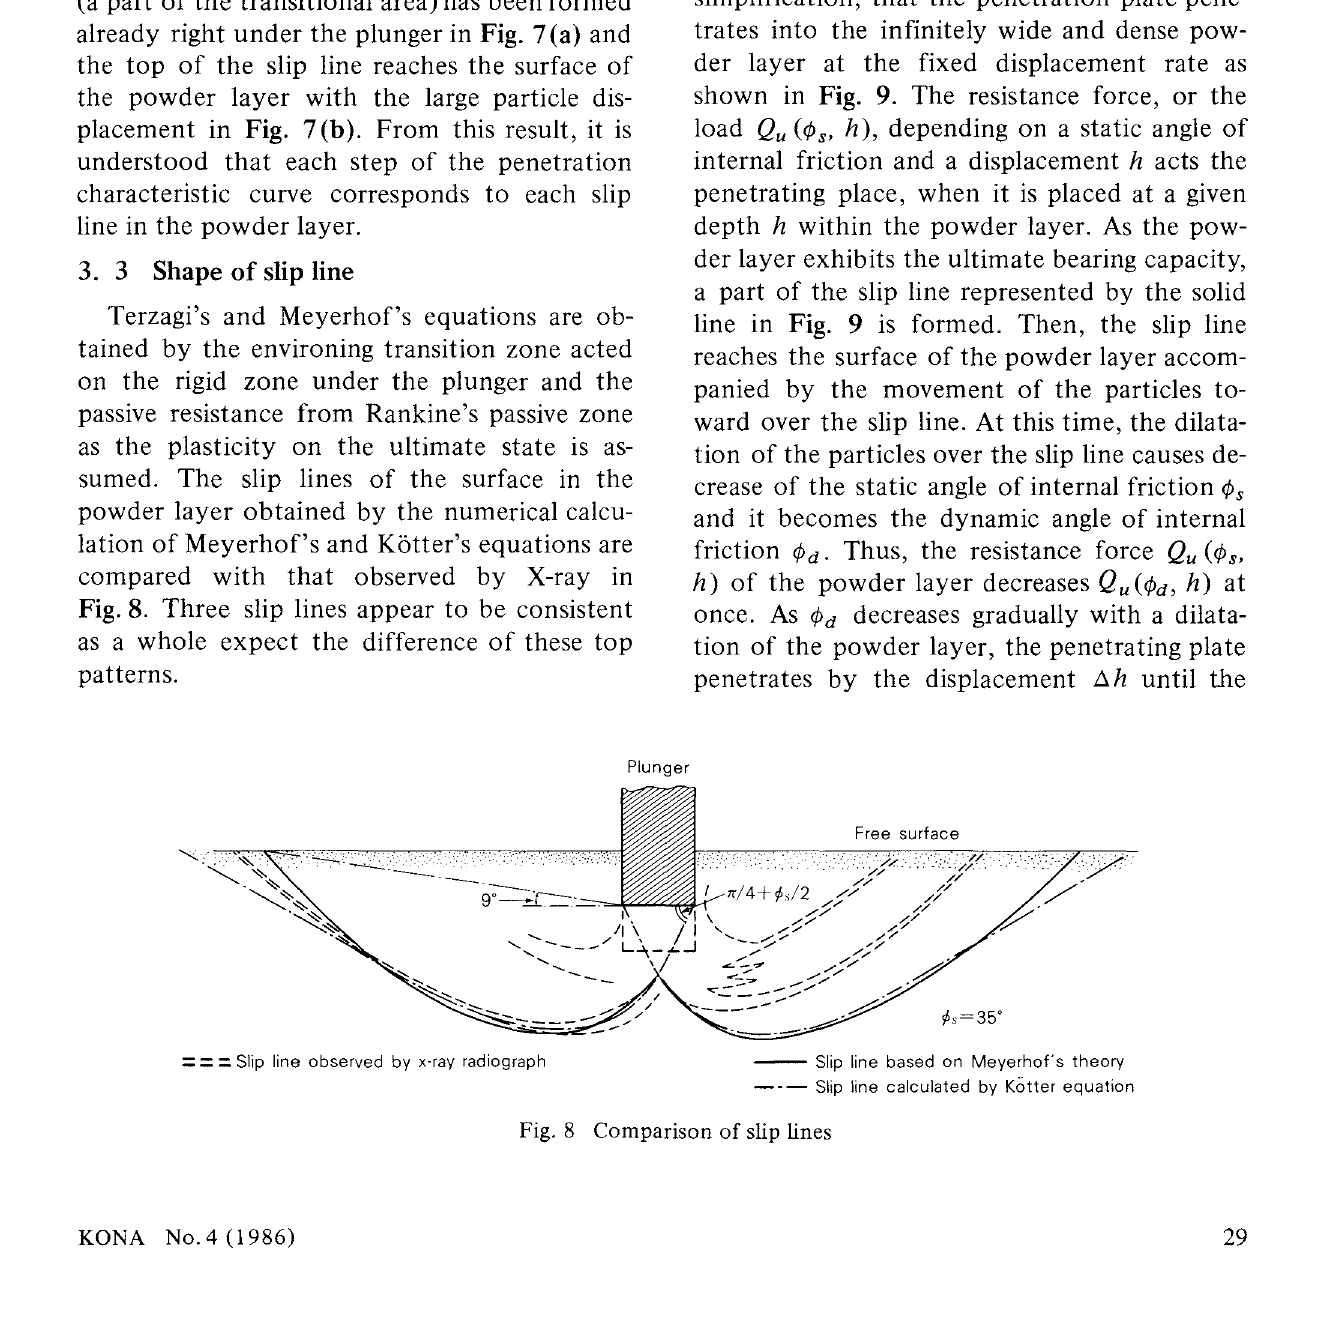
Fig. 8 Comparison of slip